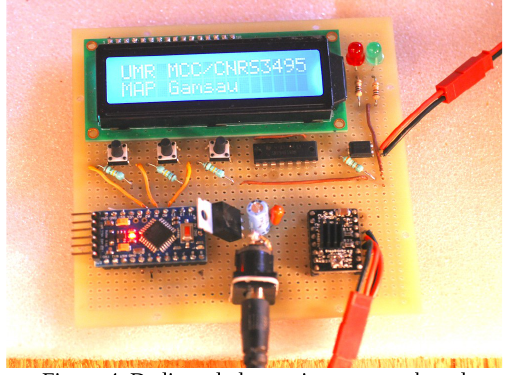
Figure 4: Dedicated electronic prototype board